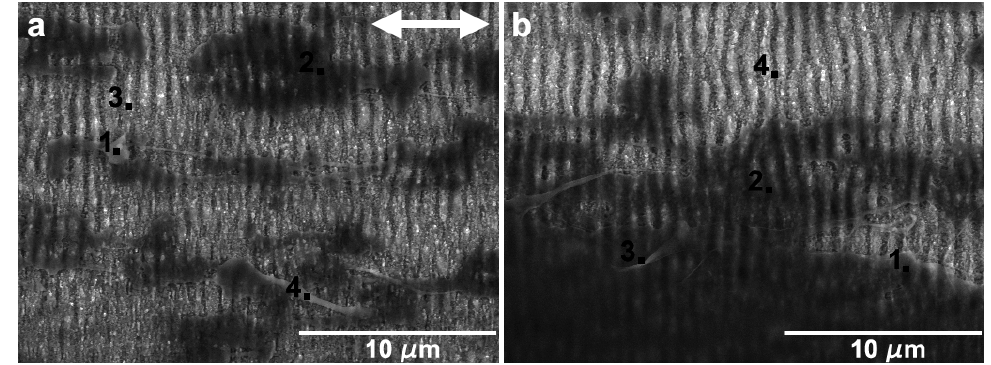
Figure 16. EDS point analysis on wear tracks performed with ( a ) 1000 cycles at 10 mN cycles and ( b ) 400 cycles at 25 mN. The double arrow indicates the sliding direction.